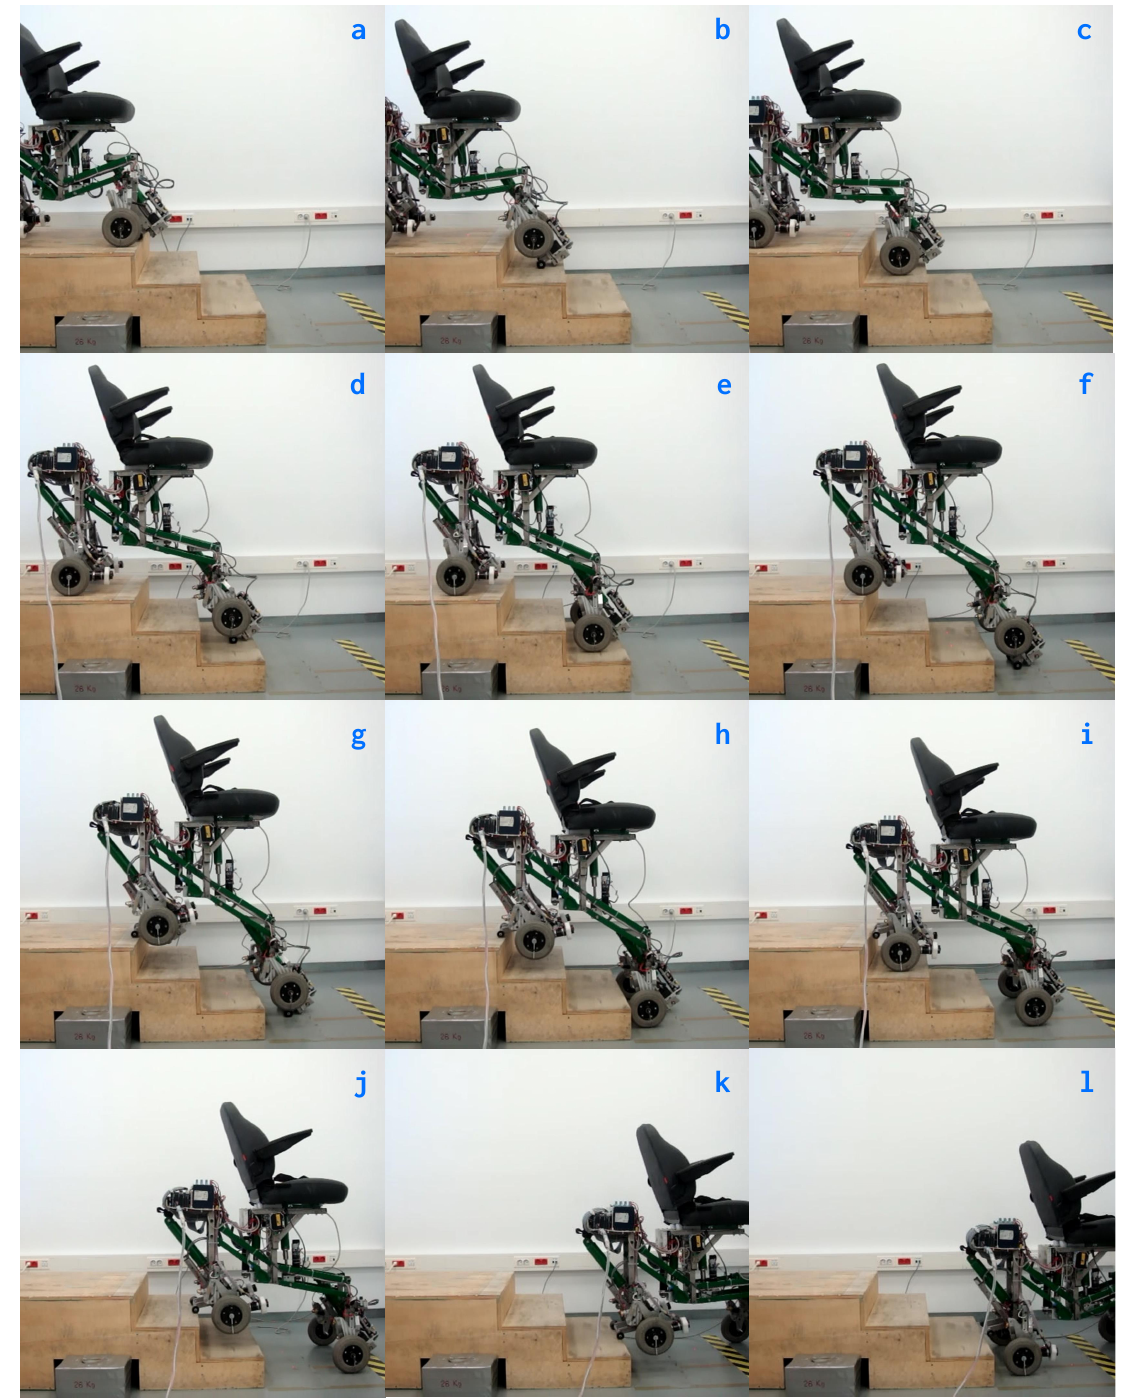
Figure 20. Sequence of descent process when it surpasses a three-step staircase. All possible configurations of the SCMS are included; Configuration 1 in ( a , c , e , i , l ); Configuration 2 in ( h , j , k ); Configuration 3 in ( b , d , f ); and Configuration 4 in ( g ). See the video referenced in the Supplementary